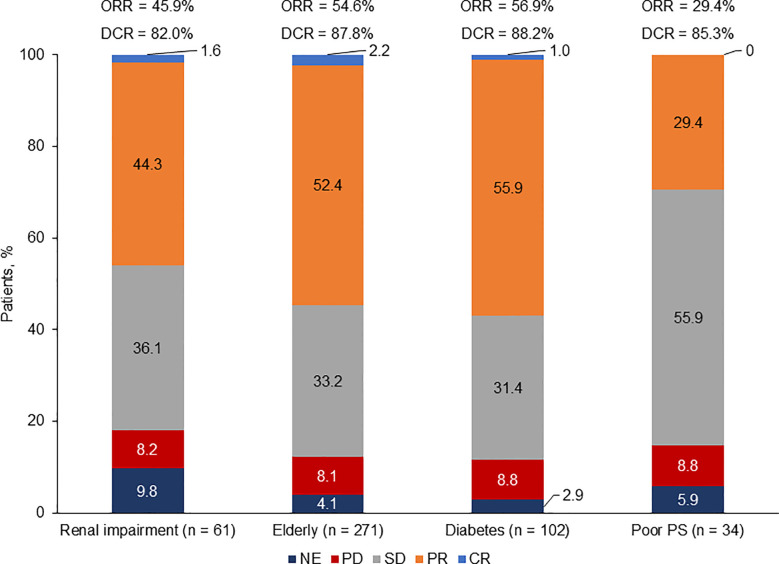
Response rate by population. CR, complete response; DCR, disease control rate; NE, not evaluable; ORR, overall response rate; PD, progressive disease; PR, partial response; PS, performance status; SD, stable disease. Based on patients with baseline and at least one post baseline tumor assessment.